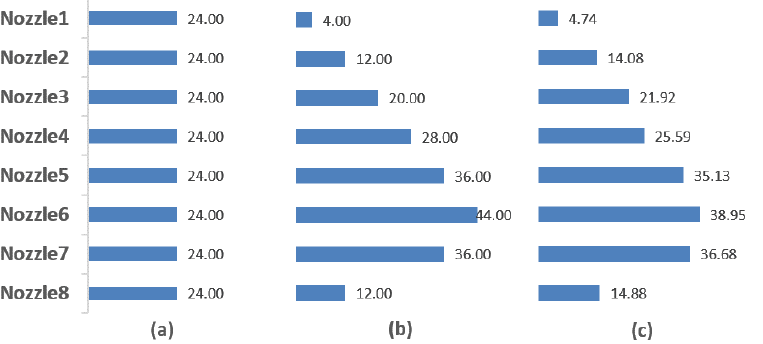
Figure 16. AIG nozzle flow-rate for the lower-skewed profile (unit, m/s). ( a ) Constant injection; ( b ) adjusted injection; ( c ) optimized injection. Table 4. RMS of NH 3 /NO molar ratio at the inlet of the catalyst layer for the lower-skewed profile. Constant Adjusted Optimized M rms (%) 45.2 12.1 6.98